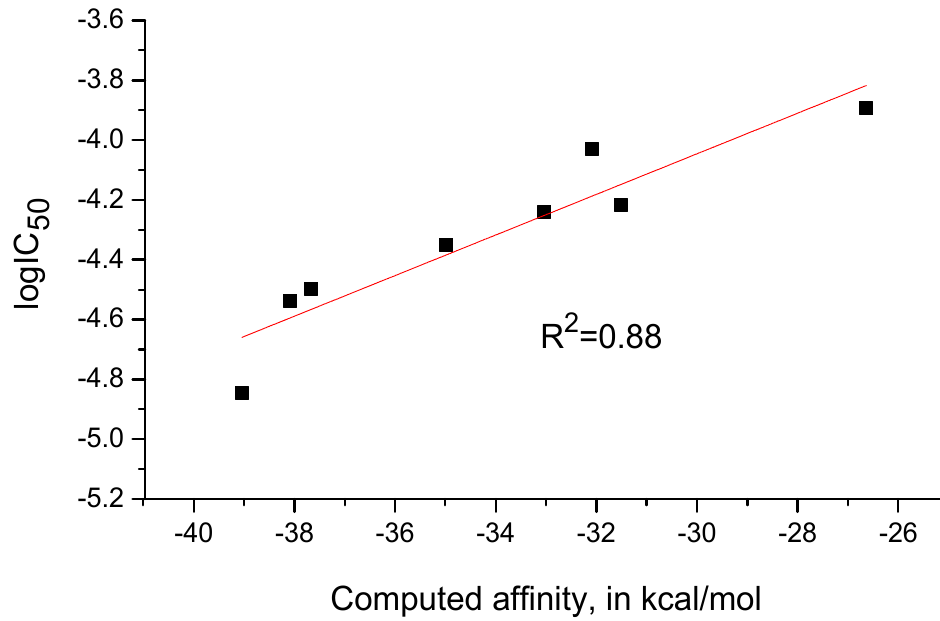
Figure 2. Plot of calculated wB97XD ligand affinities against log (IC 50 ) for compounds 1–8 ; R = 0.9357, R 2 = 0.8756.